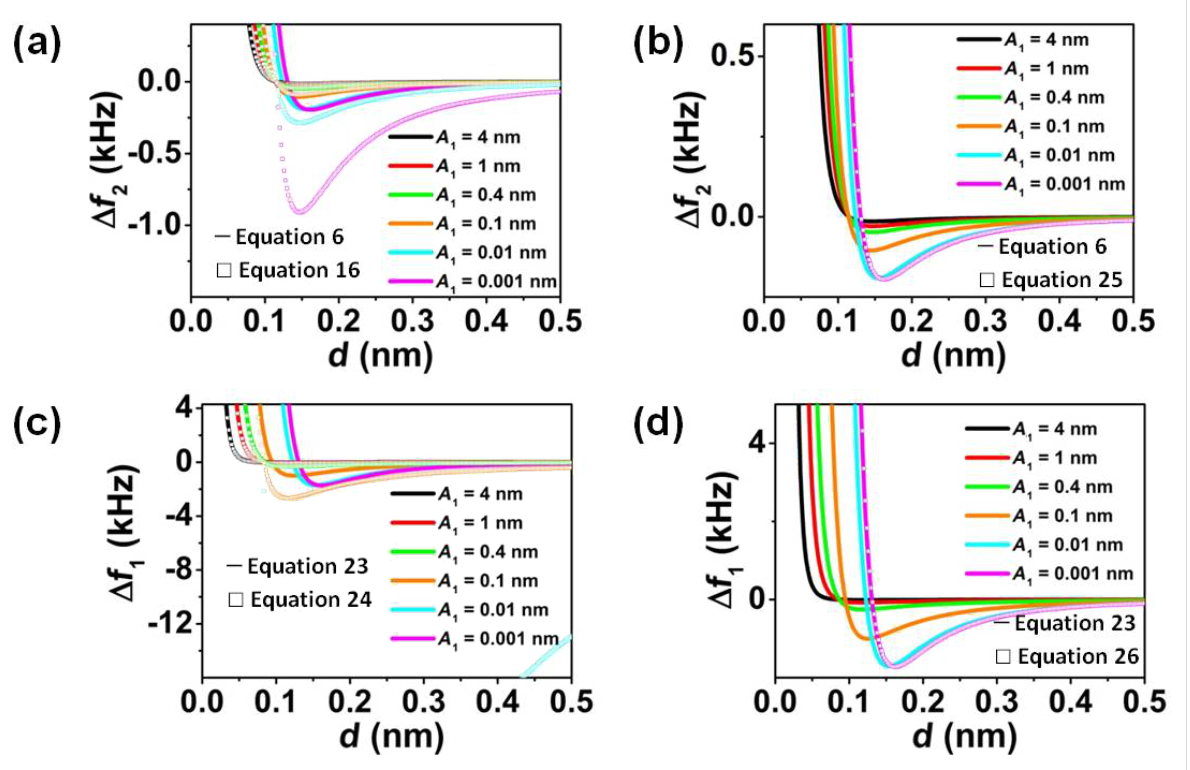
Figure 5: Comparison between the general expression for the frequency shift of the second mode in bimodal FM-AFM (Equation 6) and the (a) half- derivative relationship (Equation 16) and (b) derivative relationship (Equation 25). Comparison between the general expression for the frequency shift of the first mode in bimodal FM-AFM (Equation 23) and the (c) half-integral relationship (Equation 24) and (d) derivative relationship (Equation 26) for different A 1 and a Lennard-Jones force characterized by ε = 0.5 · 10 − 20 J and σ = 0.1 nm, A 1 / A 2 = 5000.